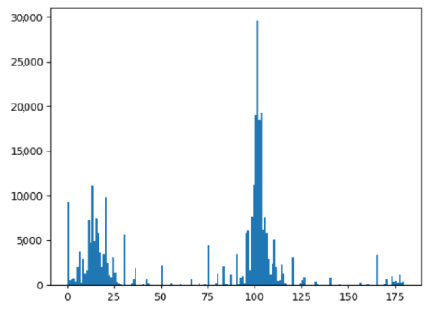
Figure 4. Histogram of HSV images.